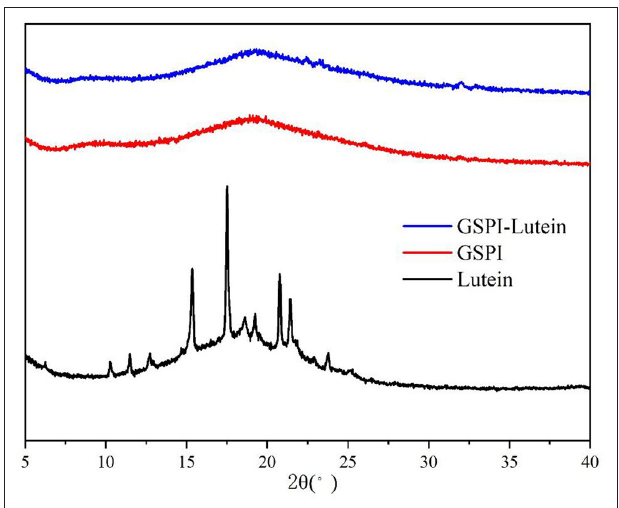
FIGURE 5 | X-ray diffraction of lutein, GSPI, and GSPI–lutein.